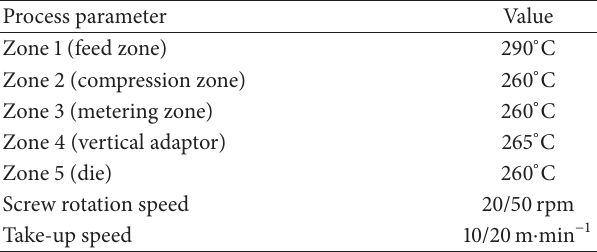
Table 1: Extrusion parameters for PET “grade